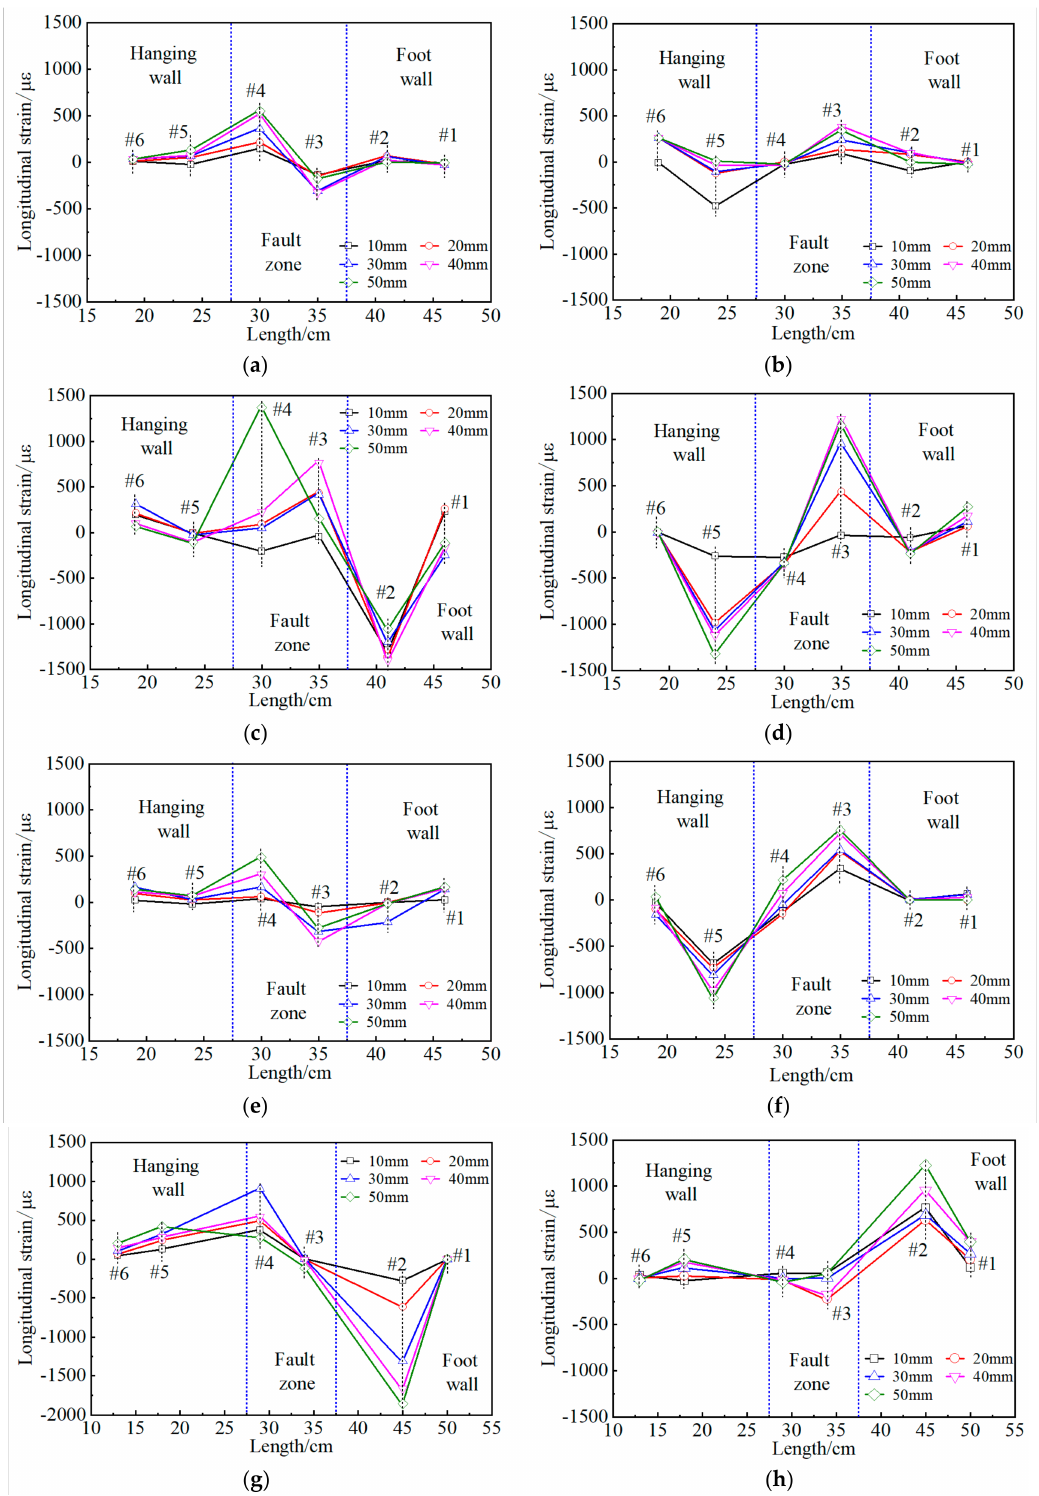
Figure 11. The longitudinal strain of a tunnel with flexible joints under different fault displacements. ( a ) Case 1, left wall; ( b ) Case 1, right wall; ( c ) Case 2, left wall; ( d ) Case 2, right wall; ( e ) Case 3, left wall; ( f ) Case 3, right wall; ( g ) Case 4, left wall; ( h ) Case 4, right